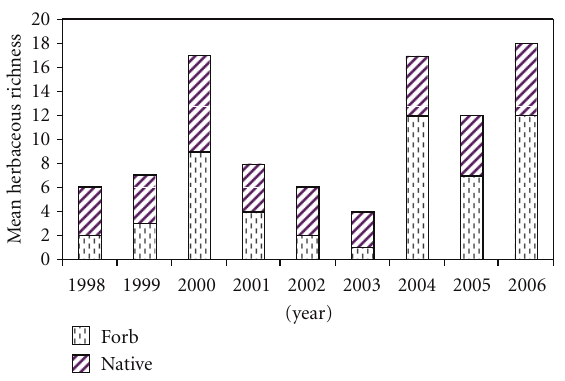
Figure 3: Mean species richness at undisturbed sites (Xade) from 1998 to 2006.